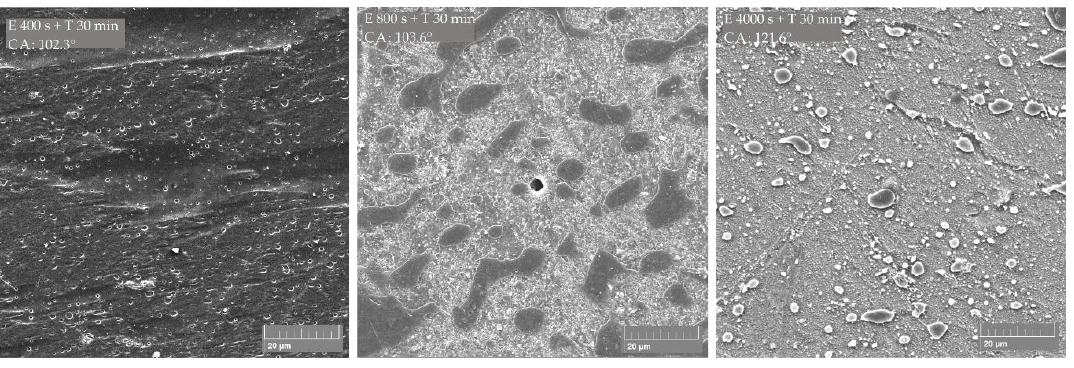
Figure 6. SEM micrographs of PLA/PE-HD 90/10 polymer blend treated by etching (E) and CF x coating (T); measured contact angle is indicated as CA